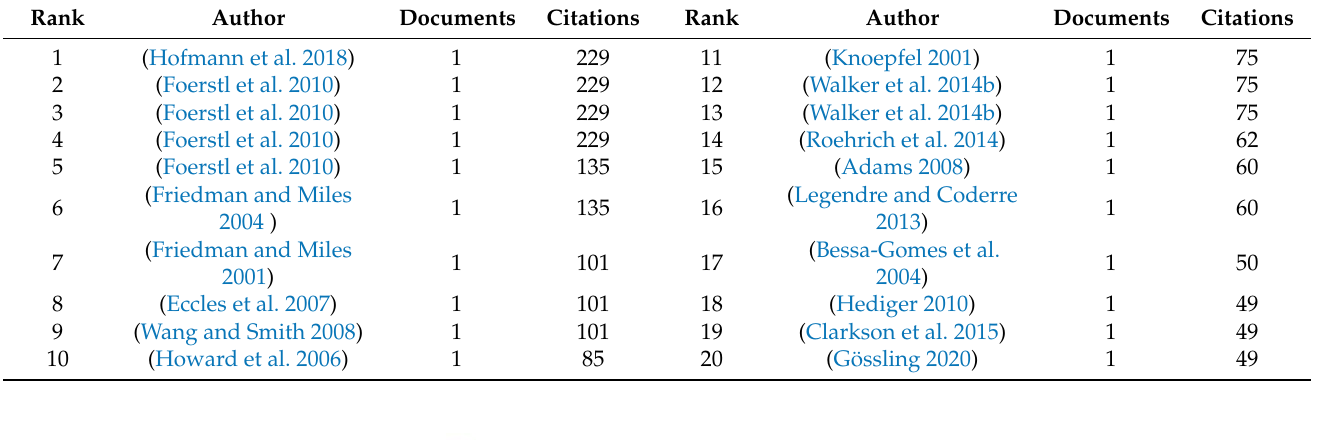
Table 3. Top cited authors.